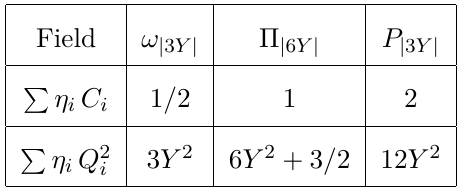
Table 6 . Values of P η i Q 2